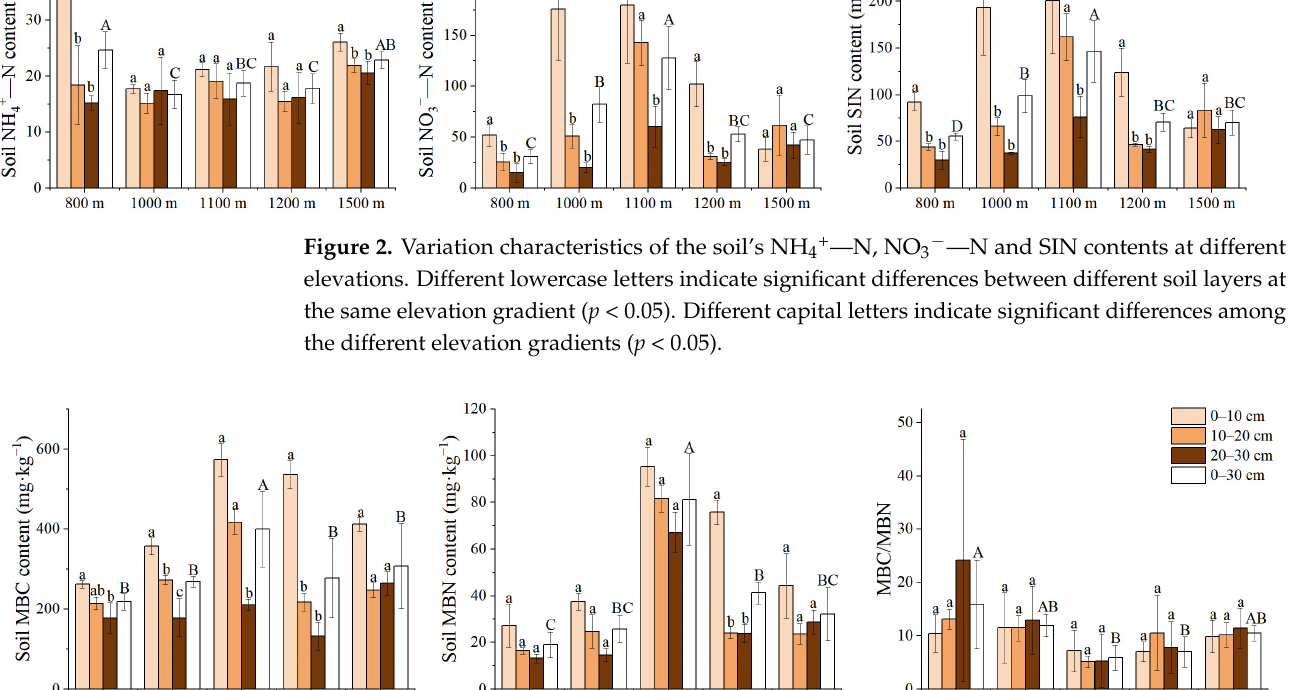
Figure 2. Variation characteristics of the soil’s NH 4+ —N, NO 3 − —N and SIN contents at different el- evations. Different lowercase letters indicate significant differences between different soil layers at the same elevation gradient ( p < 0.05). Different capital letters indicate significant differences among the different elevation gradients ( p < 0.05).